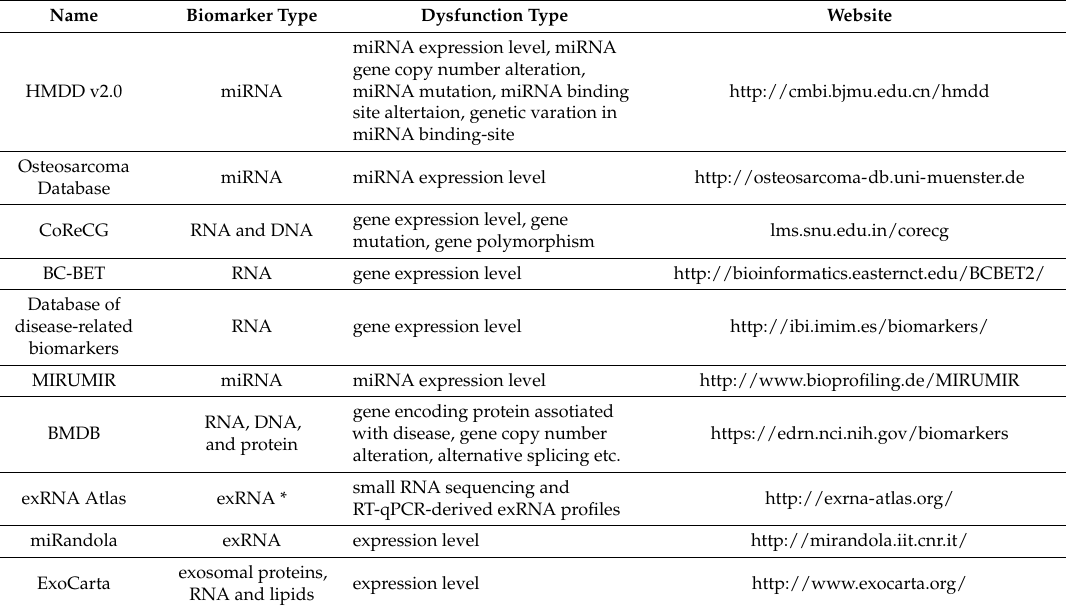
Table 4. Available database for RNA biomarkers for